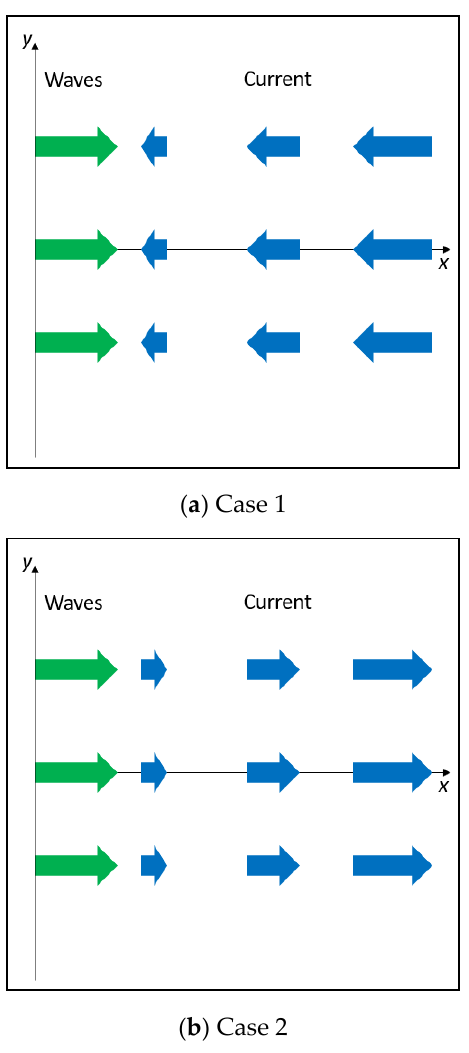
Figure 3. Schematic of wave propagation and current velocity directions for cases 1 and 2.